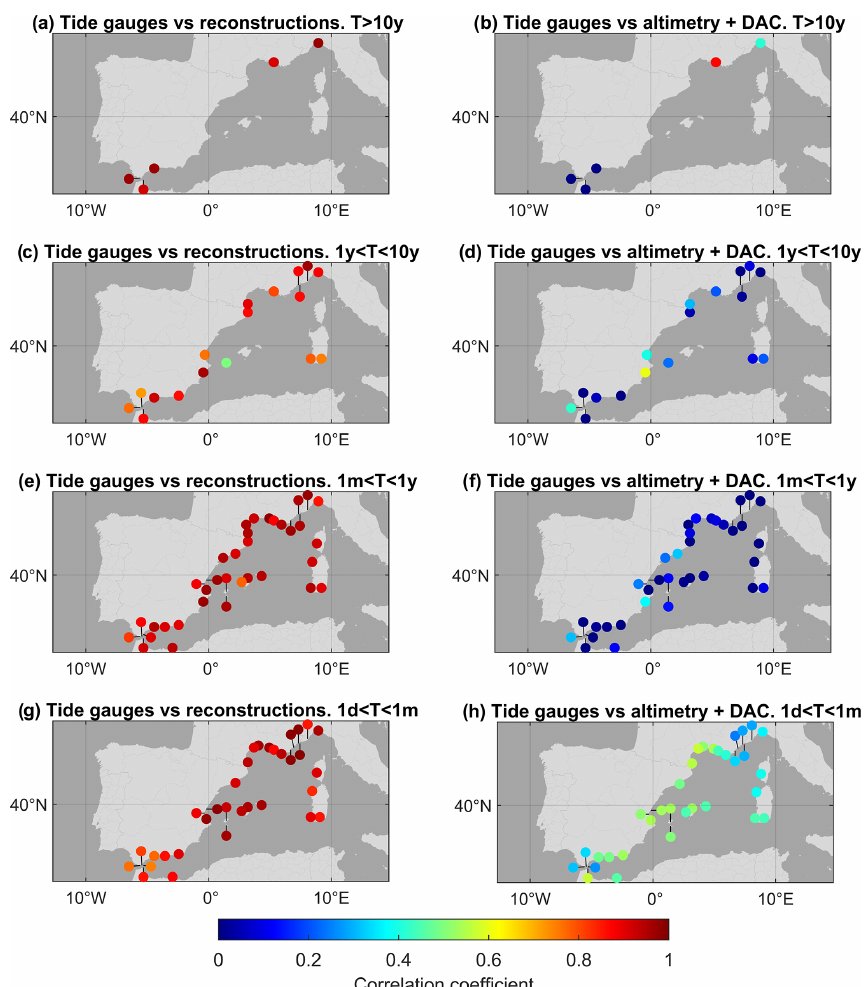
Figure 12. Correlations between the reconstructions obtained through the cross-validation test and the original tide gauge series (left) and correlations between the atmospherically corrected altimetry series and the original tide gauge series (right) for the four frequency bands.